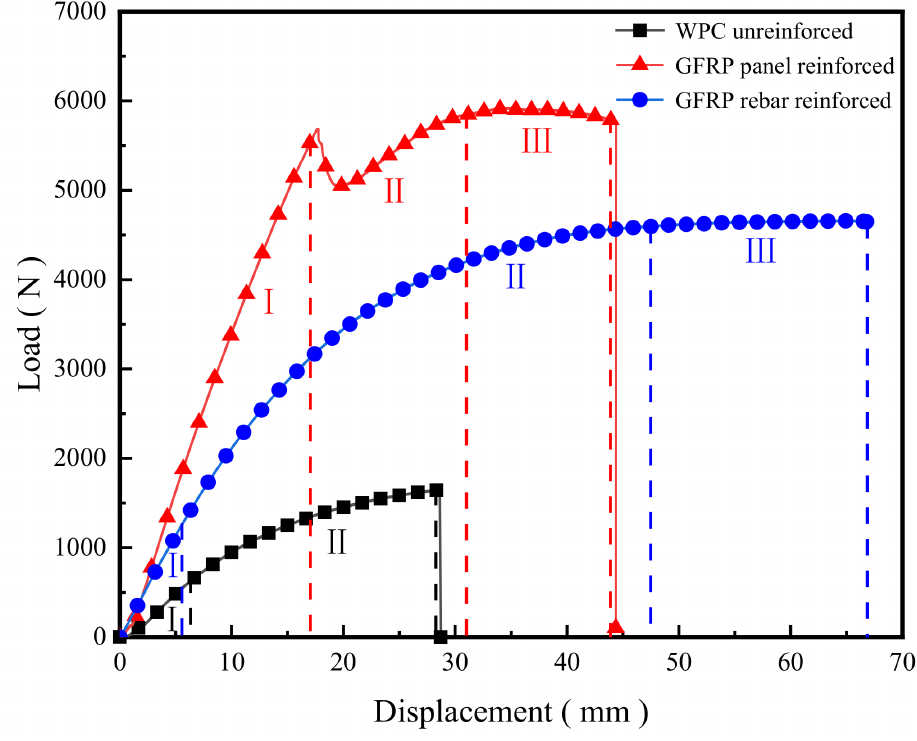
Figure 4. Load-mid-span displacement curves of WPC panels in static load